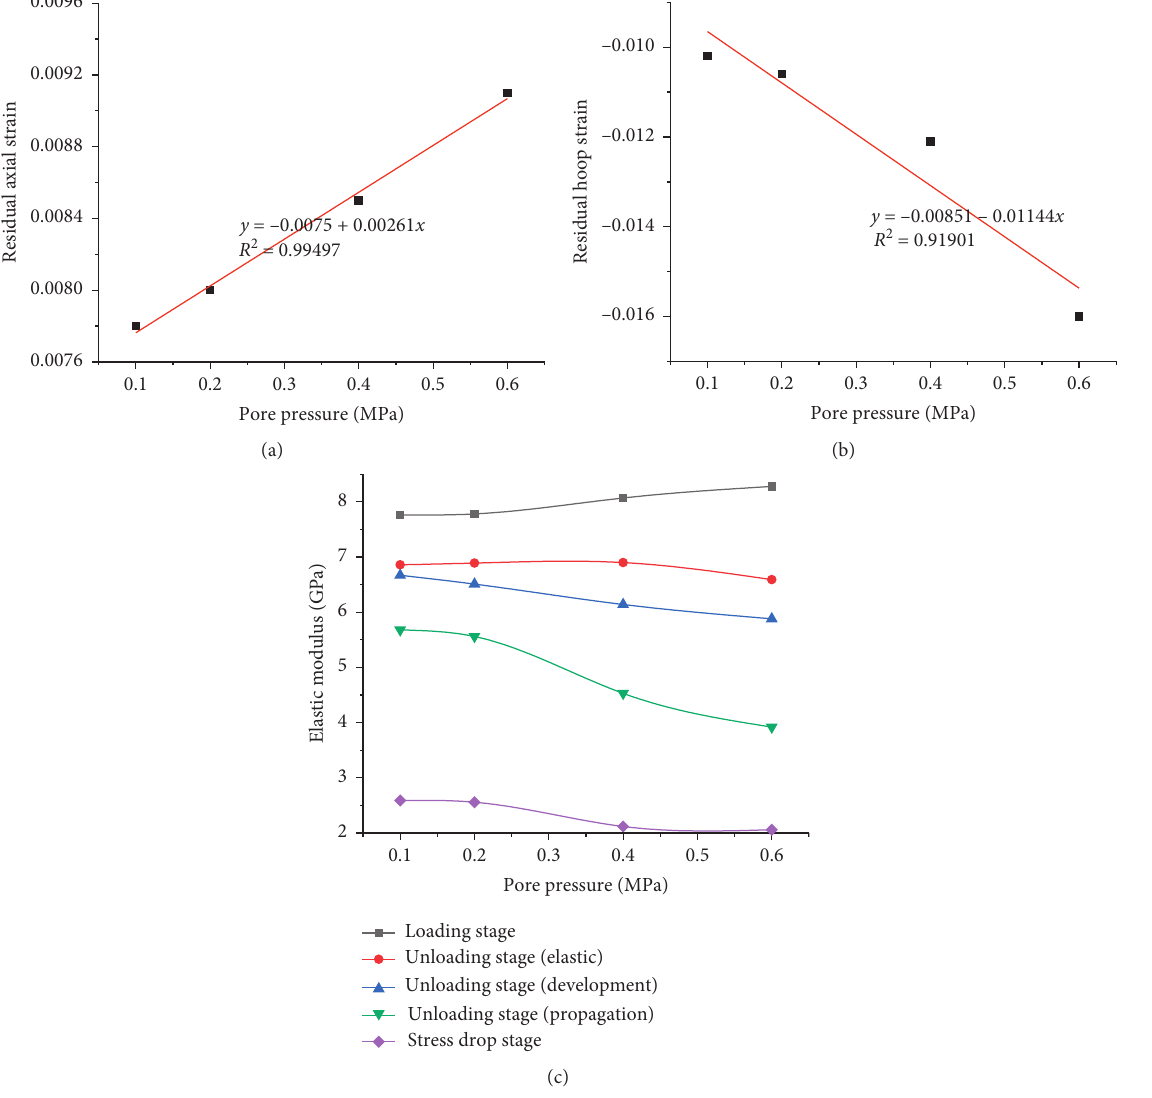
Figure 4: Variations in residual strain and elastic modulus with pore pressure. (a) Variation in residual axial strain with pore pressure. (b) Variation in residual hoop strain with pore pressure. (c) Variation in elastic modulus with pore